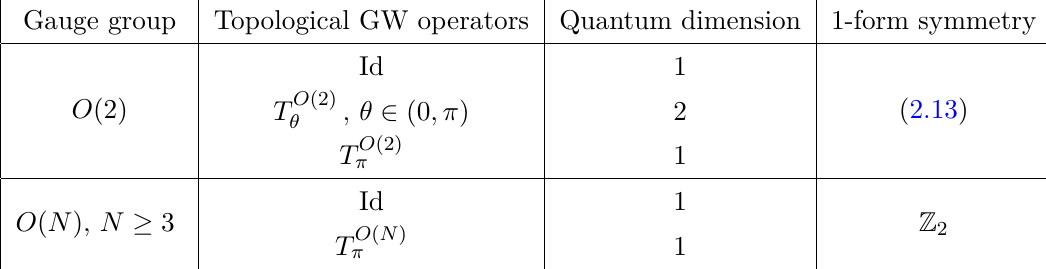
Table 2 . Summary of topological Gukov-Witten operators for theories with O ( N ) gauge group. “ T O (2)